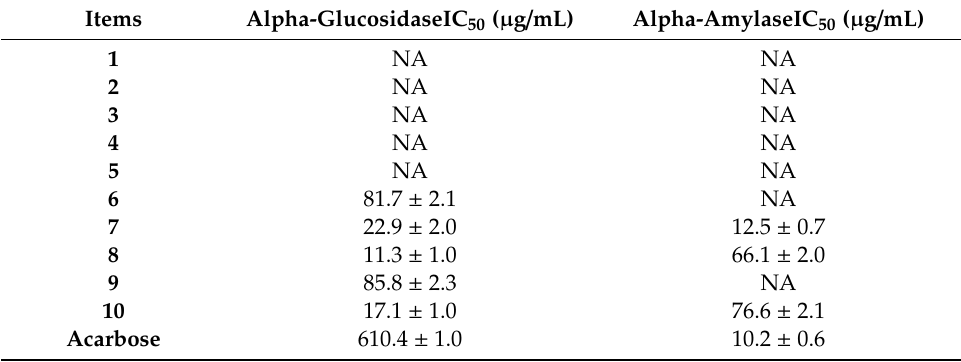
Table 3. Inhibitory activities of the isolated compounds on alpha-glucosidase and